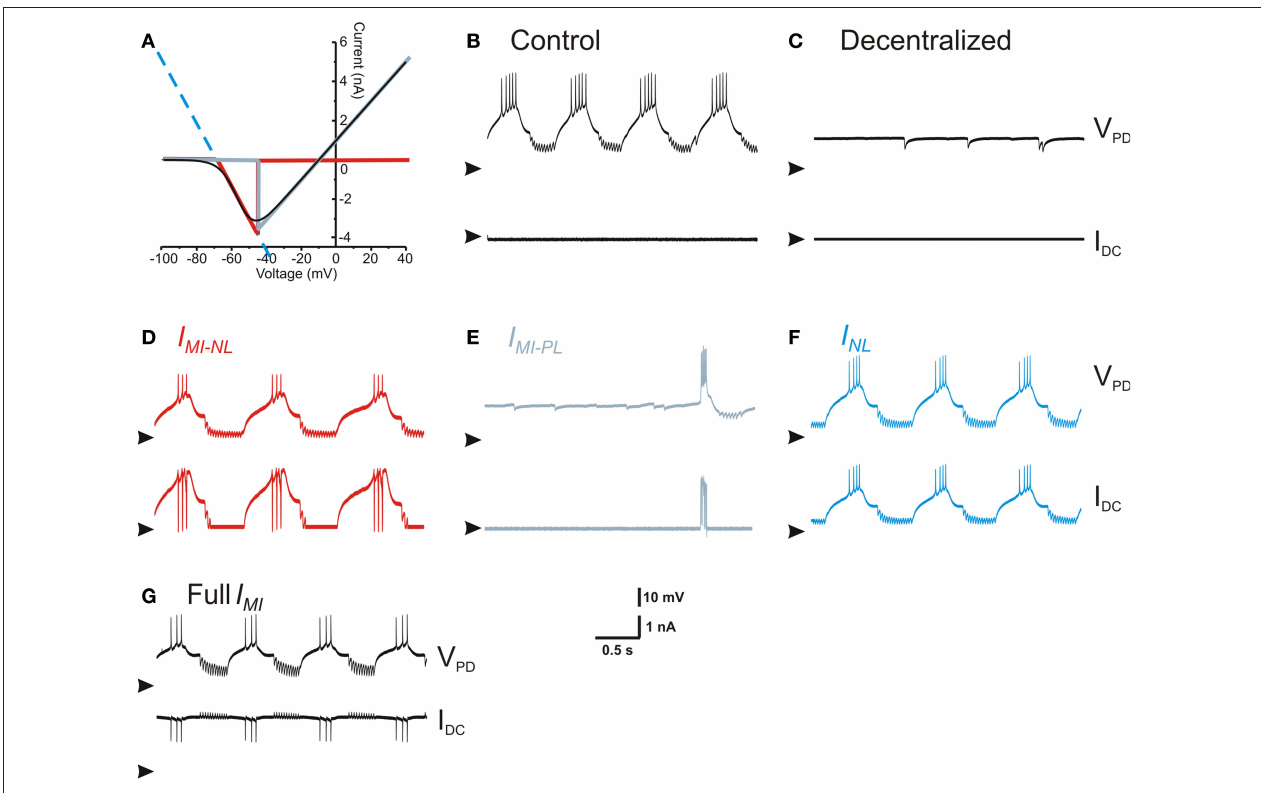
Figure  | effect of negative leak conductance and modulatory-activated inward current linear components. (A) I–V curve of I and its linear MI approximations. Full I is the black trace, I is the dashed blue line that extends MI NL across the entire voltage range, I is the red trace, and I is the gray trace. MI–NL MI–PL (B) Control conditions. (C) Activity after decentralization. (D) Activity with I injected (red trace in (A) , g = − 80 nS). (e) Activity MI–NL NL